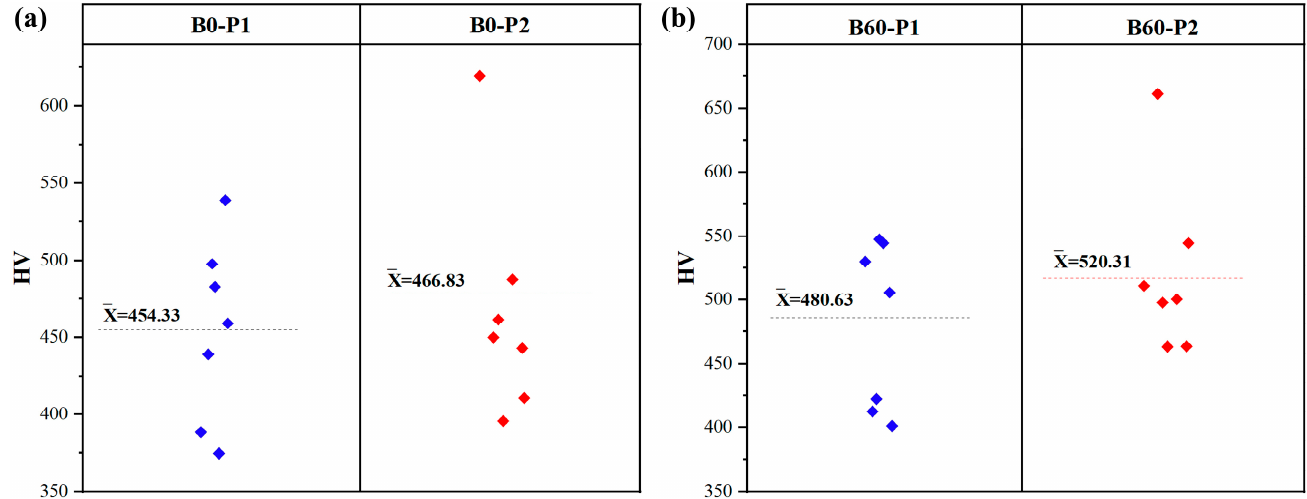
Figure 16. Vickers microhardness results for the complex phase (CP) steel heat-treated by the quenching and partitioning (Q&P) process: ( a ) boron-free steel produced by P1 and P2 steps, and ( b ) boron-containing steel produced by P1 and P2 steps.